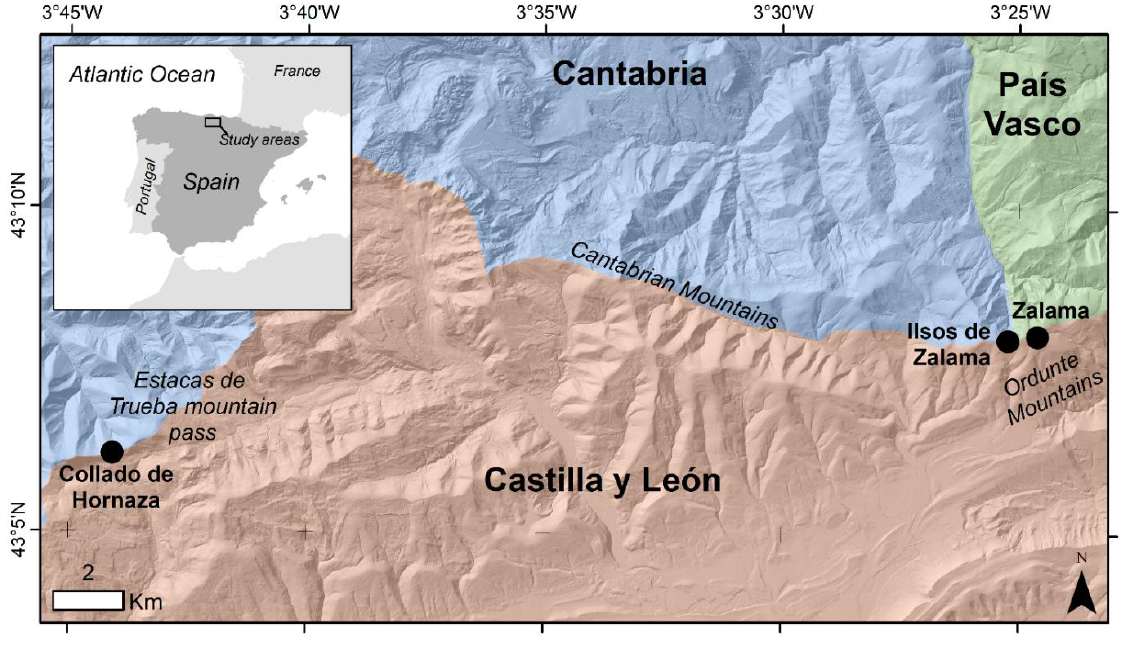
Figure 1. Locations of the three study sites, namely Zalama blanket bog, Ilsos de Zalama blanket bog and Collado de Hornaza blanket